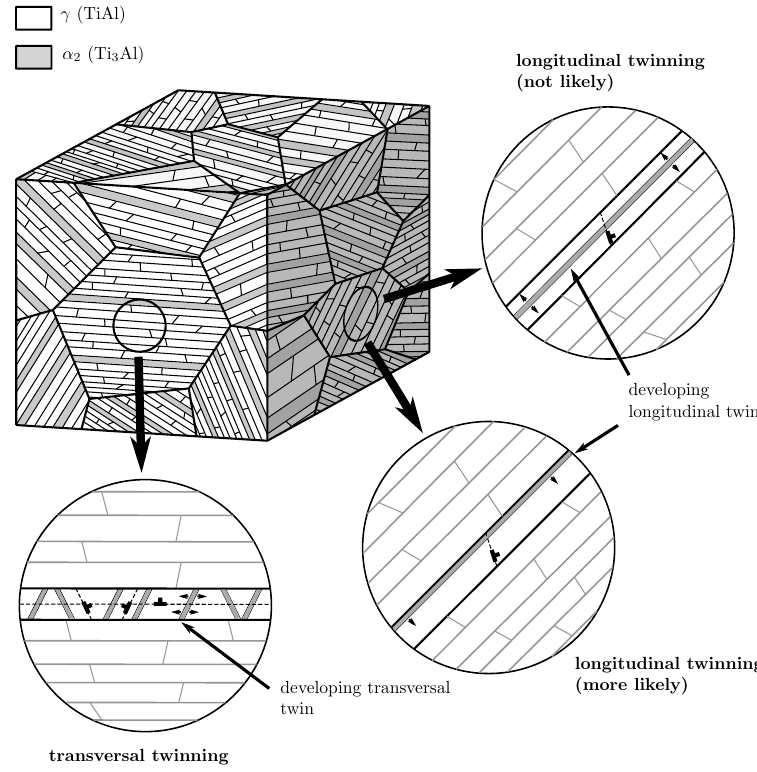
Figure 7. Comparison of possible evolutions of longitudinal and transversal twins in γ